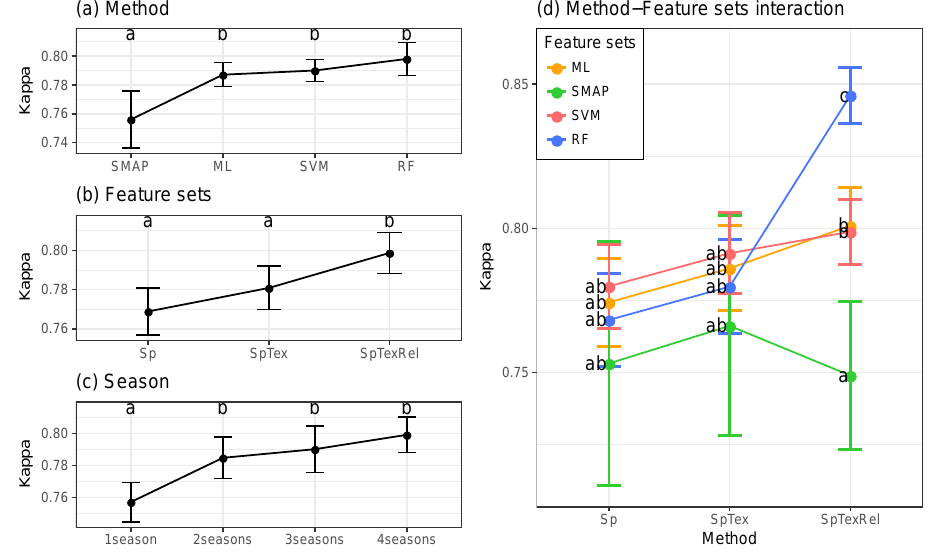
Figure 8. Main effects and simple effects in significant factors (mean ± ). Means with different letters are significantly different (Tukey–Kramer contrast using HC3, alpha = 0.05). Number of classifications: